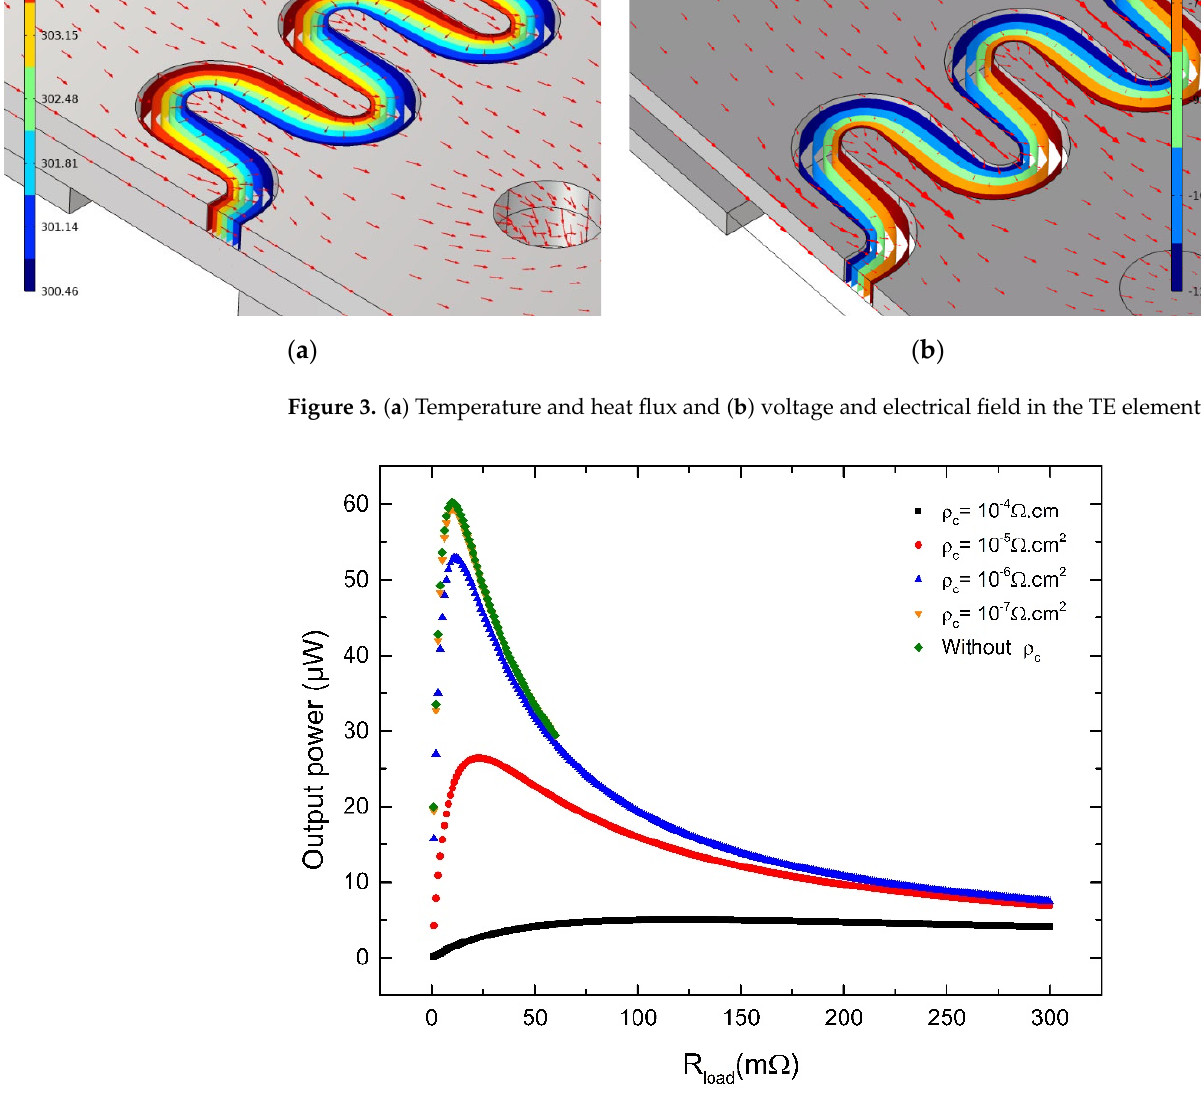
Figure 4. Output power as a function of the load resistance, R load , for various electrical contact resistances ρ c .